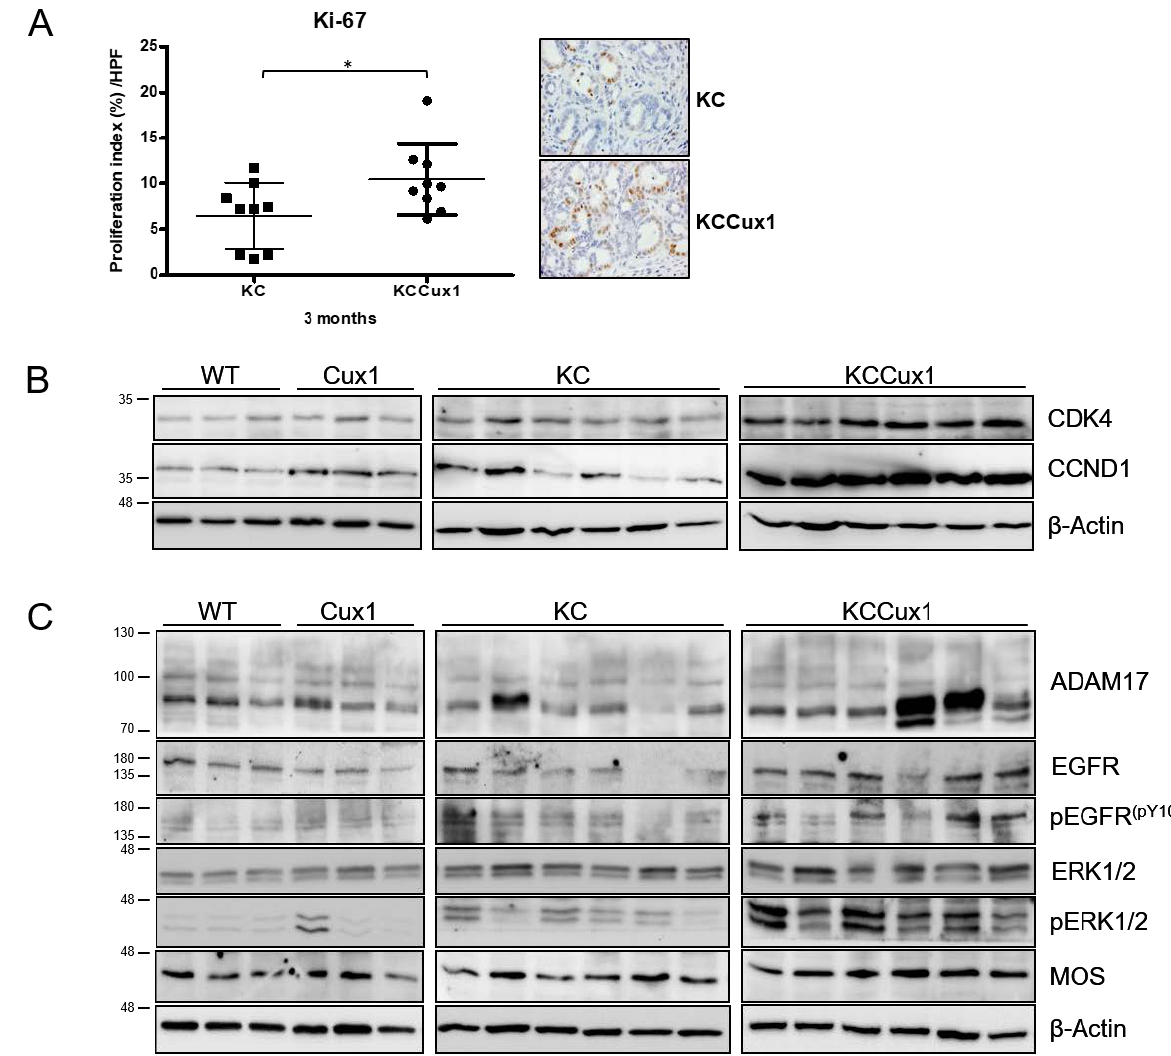
Figure 4. CUX1 potentiates KRAS-driven proliferation during PanIN progression. ( A ) Analysis of Ki-67 in PanIN areas of 3-month-old KC (grey; n = 9) and KCCux1 (black; n = 9) mice, with representative immunohistochemistry stainings (right). * p ≤ 0.03 by t -test. Data shown as mean ± SD. Symbols: dots indicate Ki-67-positive cells (%) per high-power field from each animal; the black horizontal line represents the mean percentage for each group. ( B , C ) Western blot analysis of whole pancreas protein lysates from 3-month-old WT, Cux1, KC and KCCux1 mice for proliferation markers CCND1 and CDK4 ( B ), as well as upstream signaling effectors EGFR, pEGFR and ADAM17 and their downstream effectors ERK, pERK and MOS ( C ). Actin served as control. The uncropped Western Blot images can be found in Figure S9 and the densitometry analysis can be found in Figure S10.